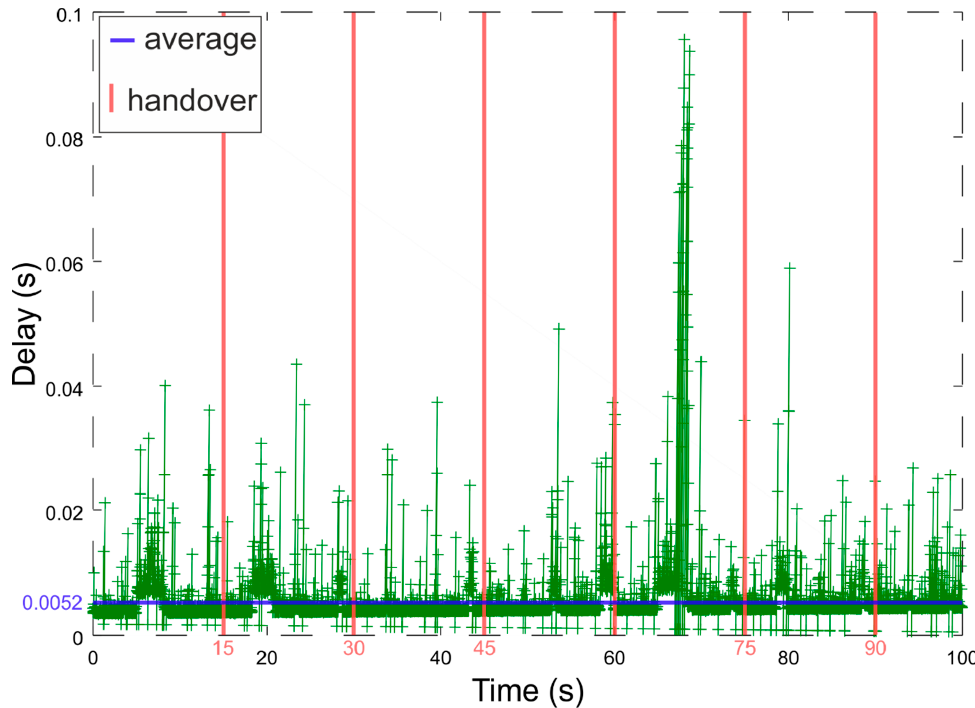
Figure 9. Delay-sensitive scenario measurement.